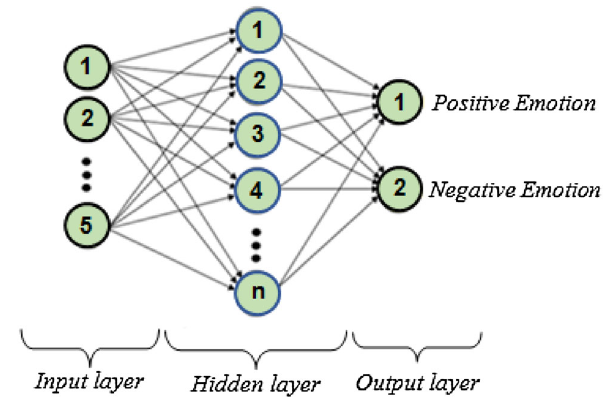
Fig. 6 MLPNN structure: (5 9 n 9 2)